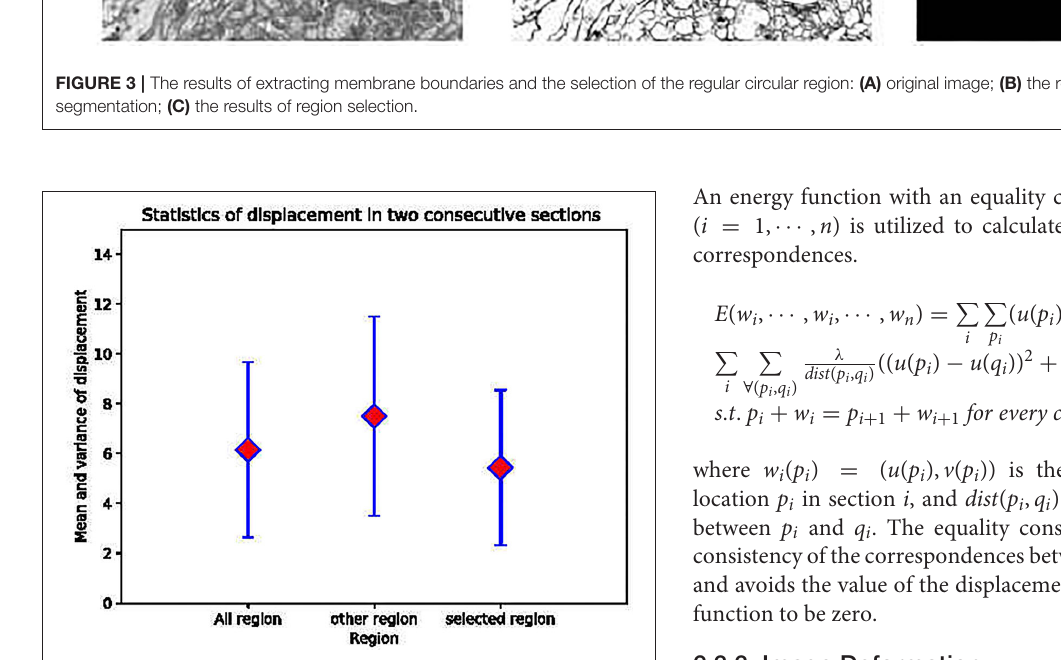
FIGURE 4 | The mean and the variance in the displacement between the regular circular areas, other areas and the whole image in two consecutive